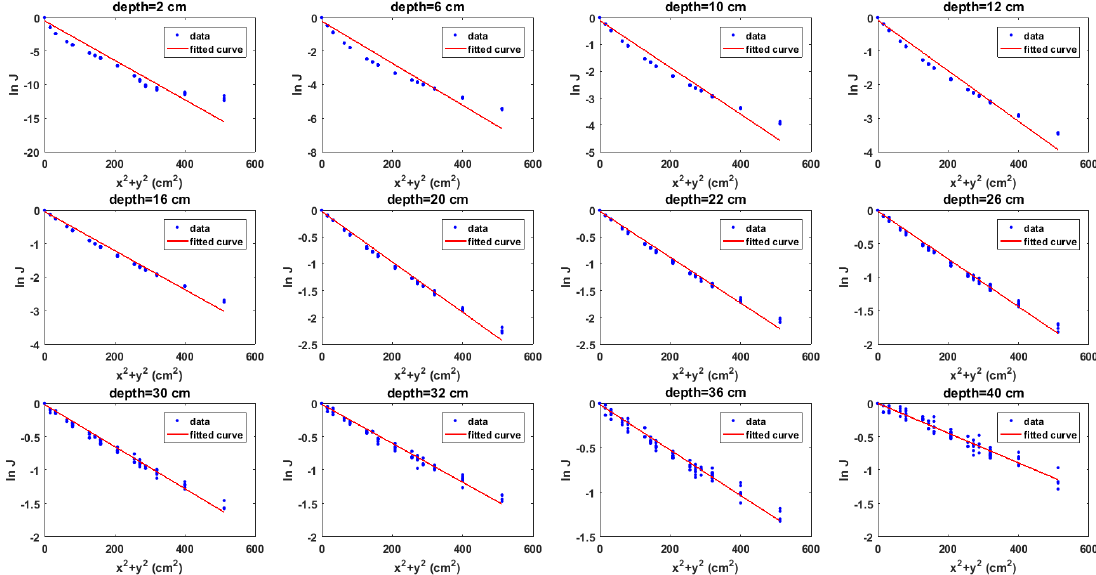
Figure 5. Plots of model for Cs-137 buried in sand for selected depths. From left to right: 2 cm, 6 cm,